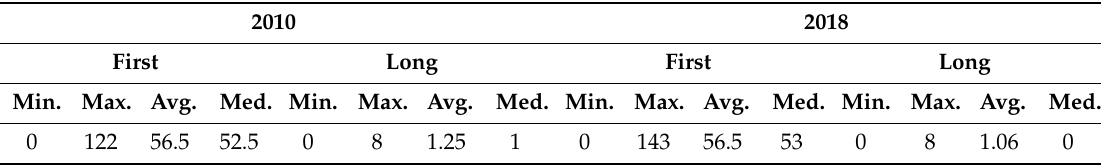
Table 6. First and long precedencies by years.